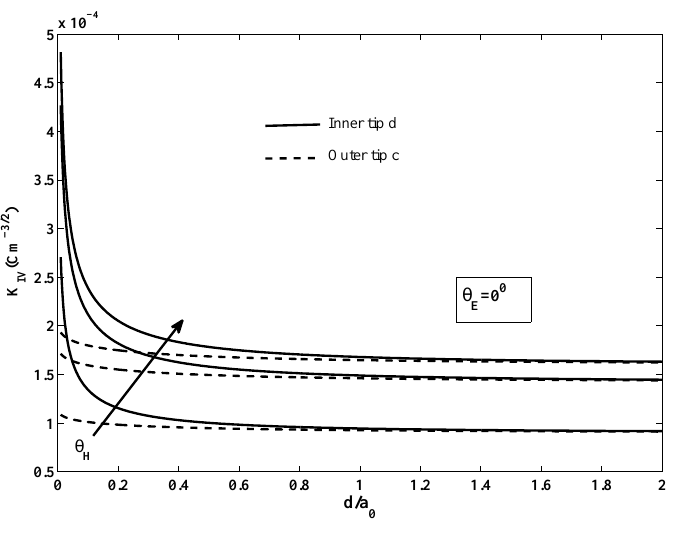
Fig. 14 EDIF versus inter-crack distance for different magnetic poling with fixed electric poling